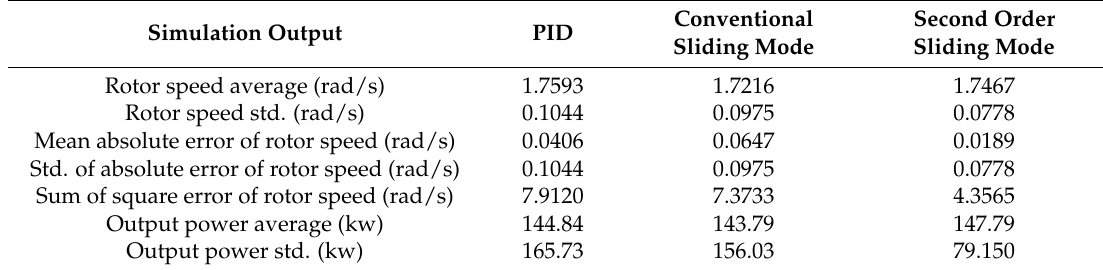
Table 5. Simulation results of turbine rotor speed, speed error and output